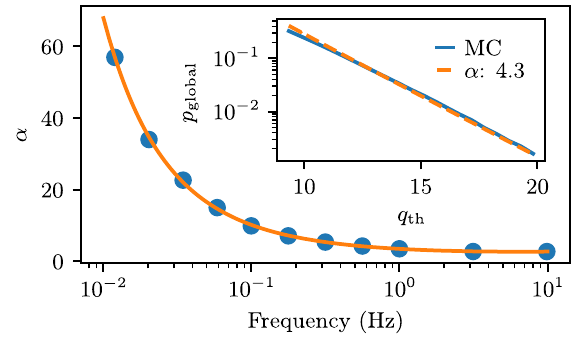
FIG. 4. Main figure: blue circles give α as computed for that particular frequency. The orange line shows the interpolating function for α ð ν Þ obtained using the blue circles. Inset: solid blue line is obtained from 100 000 null Monte Carlo datasets for axion masses centered at 0.562 Hz, while the dashed orange line shows the fit of Eq. (27) to the blue